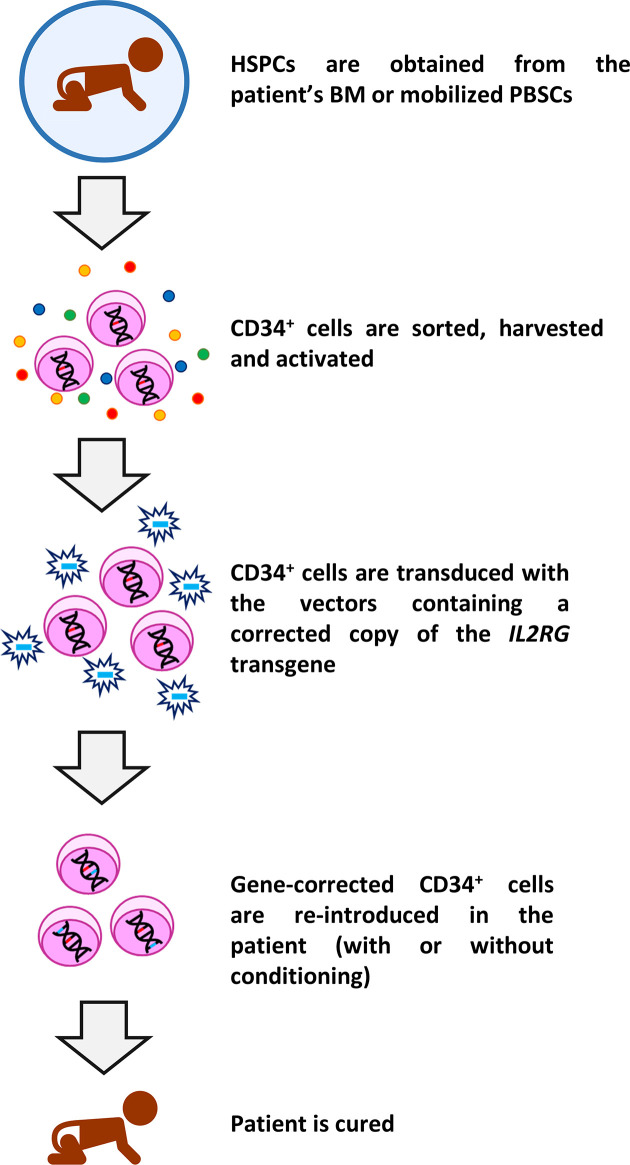
Schematic representation of gene therapy protocol used in SCID-X1 clinical trials. CD34+ HSPCs are sorted from bone marrow (BM) or mobilized peripheral blood stem cells (PBSCs) using magnetic separation and cultured with cytokines. Thereafter, cells are transduced with the specific vector containing the corrective human interleukin-2 receptor γ gene (IL2RG) and after a period of culture, the cells are re-infused in the patients. In most recent clinical trials, the cells are infused after a low-dose conditioning treatment. Subsequently, the immune reconstitution starts, and the patient is theoretically cured for life.